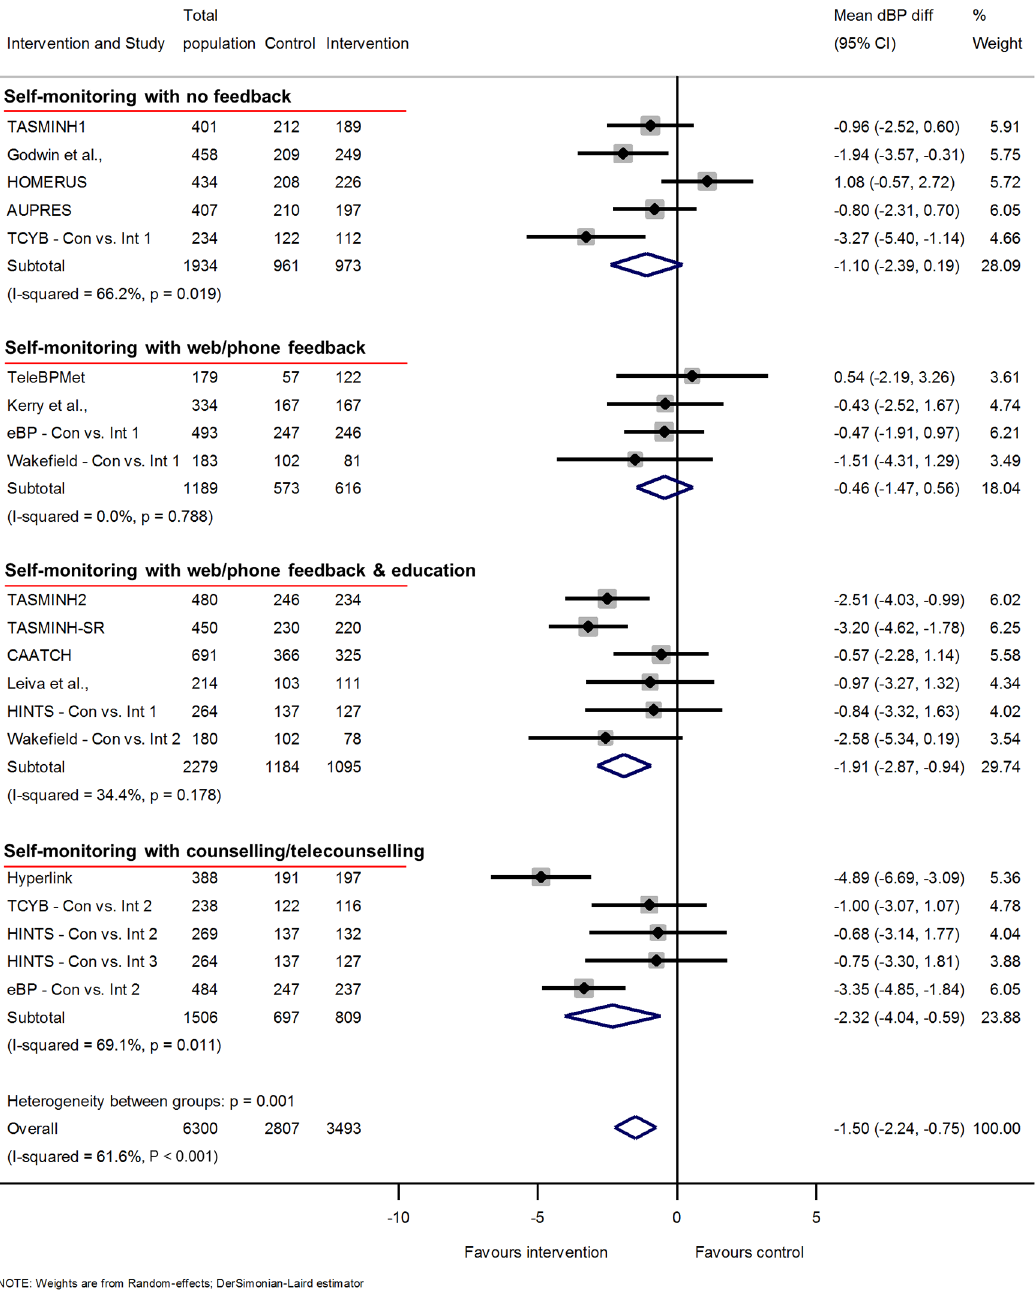
Fig 2. Impact of self-monitoring of BP on clinic dBP according to level of co-intervention support at 12 months (15 studies). Changein dBP adjustedfor age, sex, baselineclinic BP, and history of diabetes.The trials are groupedinto the 4 levels of intervention, and I 2 and P values are shown for each level of intervention and for the overall analysis. Effect of self- monitoring on clinic dBP at 6 and 18 months are shown in S4 and S7 Figs, respectively. Wakefield’s participants self- monitored for 6 months; follow-upcontinuedto 12 months. Abbreviations: BP, blood pressure; dBP, diastolicblood pressure.